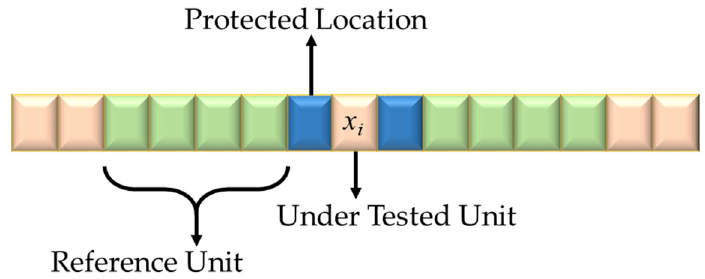
Figure 6. Average police rate projection.